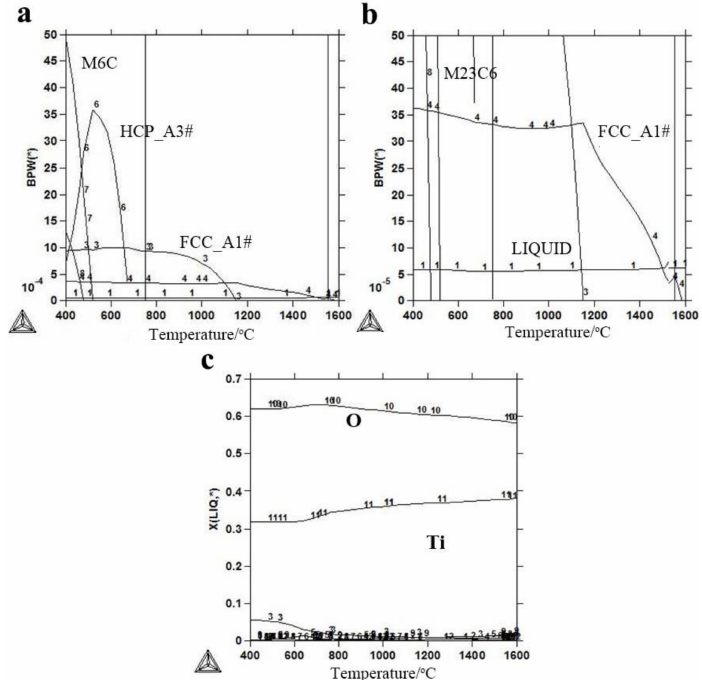
Figure 2. ( a ) The precipitated phase composition diagram and ( b ) its local magnification of Ti microalloying steel; ( c ) the elemental composition of liquid phase [59].